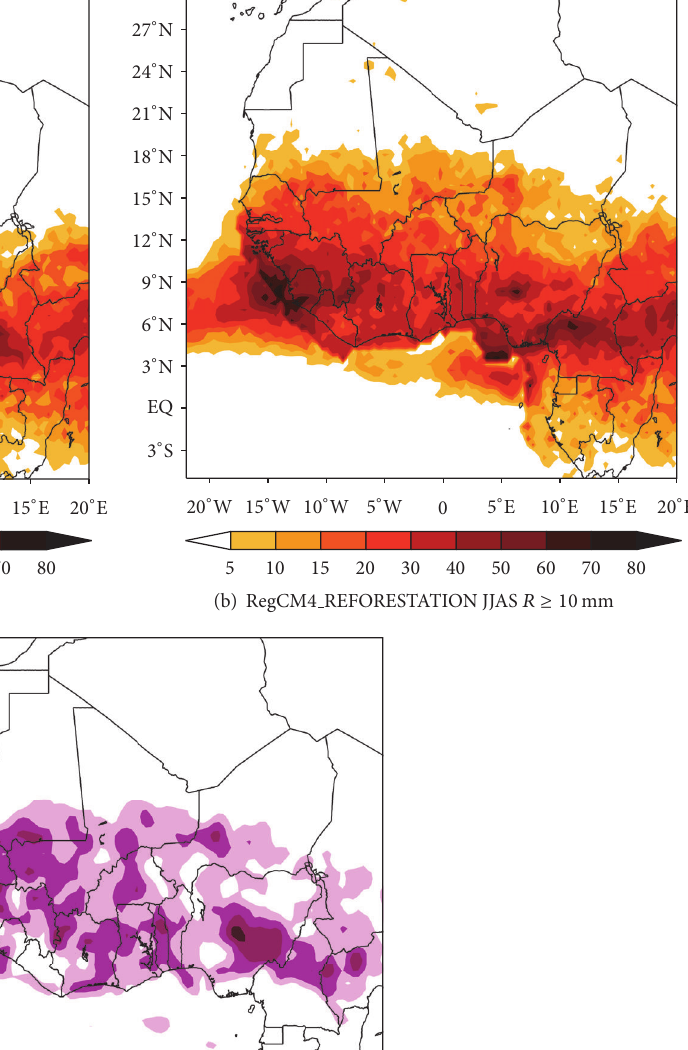
off the Fouta Jallon highlands (over the ocean). A north– south gradient with the number of rainfall events decreasing on both sides of the ITCZ is also noticed. The reforested run shows similar patterns to the standard version with a stronger northward extension of rainfall events. The analysis of the difference between the reforested and the standard versions (Figure 8(c)) shows that the reforestation tends to increase the number of rainy days roughly over a region located between the latitudes 6 ∘ N and 17.5 ∘ N and west of 5 ∘ E and especially